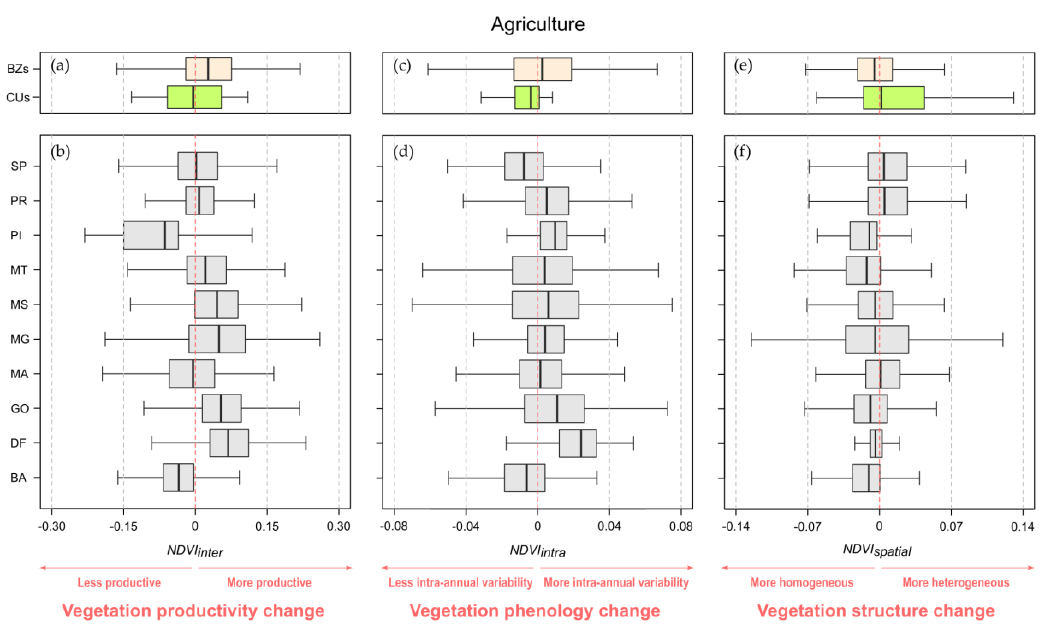
Figure A4. Boxplots of the landscape metrics’ values of the cells belonging to the ‘Agriculture’ category: ( a ) NDVI inter in the bu ff er zones (BZs) and conservation units (CUs); ( b ) NDVI inter in each state; ( c ) NDVI intra in the BZs and CUs; ( d ) NDVI intra in each state; ( e ) NDVI spatial in the BZs and CUs; ( f ) NDVI spatial in each state. Number of 250 m resolution (6.25 ha) cells located inside the 61 conservation units = 41 and in their bu ff er zones = 31,246. Number of cells in each Brazilian state with n > 0: S ã o Paulo (SP, 5161), Paran á (PR, 913), Piau í (PI, 153), Mato Grosso (MT, 2394), Mato Grosso do Sul (MS, 8489), Minas Gerais (MG, 1282), Maranh ã o (MA, 2202), Goi á s (GO, 7464), Distrito Federal (DF, 627), Bahia (BA, 2602).